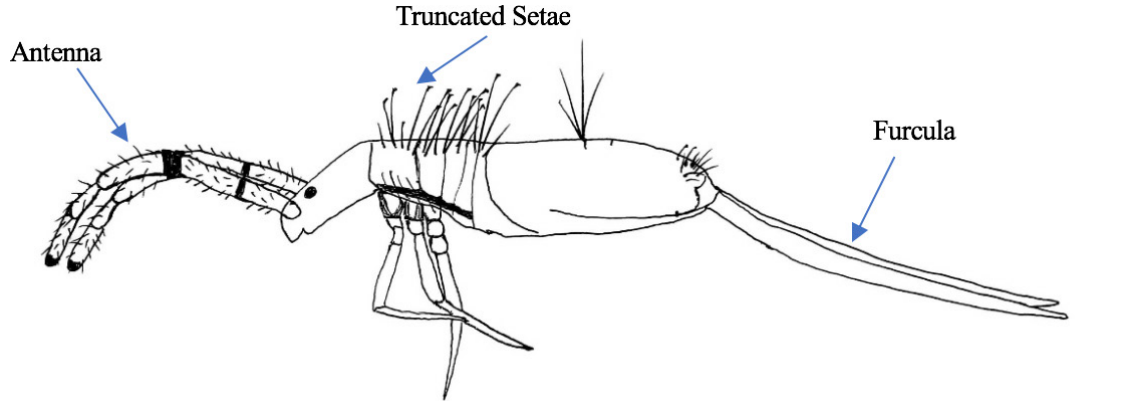
Figure 2. Dicranocentroides indica (Handschin,1929) illustration. © Ashirwad